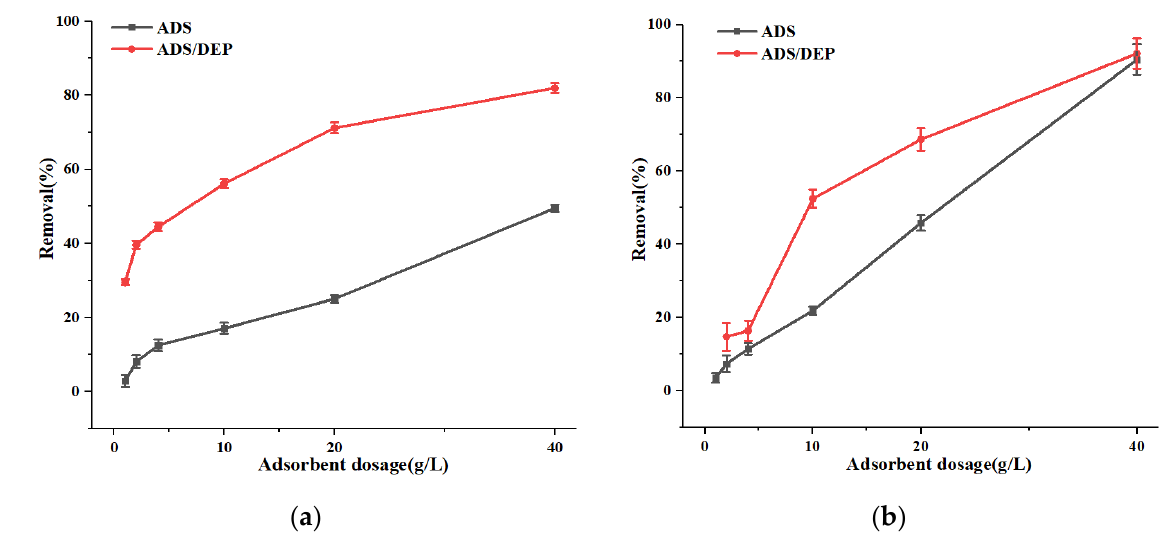
Figure 4. The effect of absorbent dosage on removal efficiency when using adsorption (ADS) alone (pH = 7, ADS time = 24 h, volume = 50 mL) or dielectrophoresis ‐ assisted adsorption (ADS/DEP) (ADS time = 1 h, volume = 500 mL, voltage = 15 V, flow = 0.503 L/h): ( a ) nitrate and ( b ) phosphate.